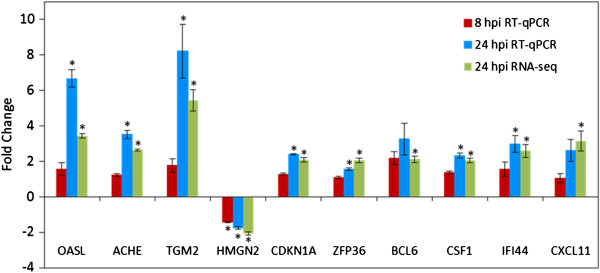
Validation of 10 selected DEGs by RT-qPCR and comparison with RNA-sequencing. RT-qPCR gene expression levels at 8 and 24 hpi were compared to mock infected cells. Fold changes were obtained by merging the mean values of 4 replicates for each time point, previously normalized to the expression of the 3 reference genes ABL, B2M and RSP7. Stars indicate significant (p < 0.05) expression changes.